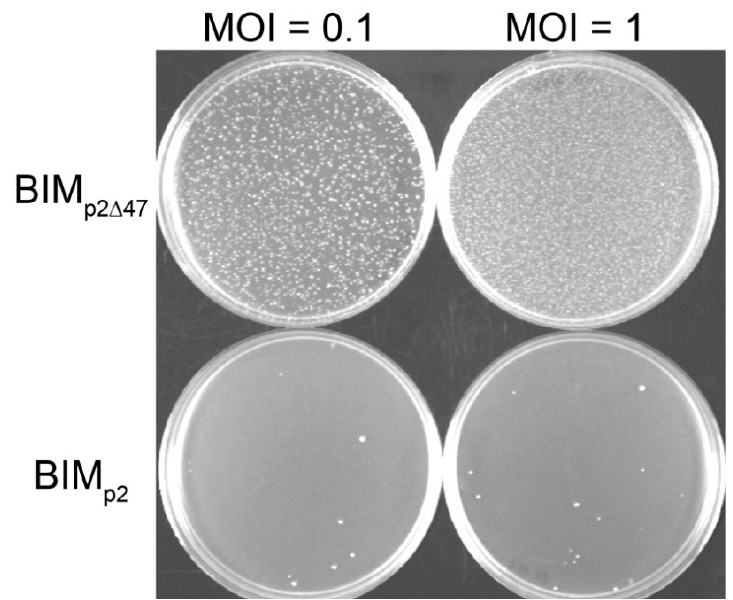
Figure 3. Frequency of natural BIMs generated following the infection by either phage p2 or phage p2 ∆ 47. The number of BIMs obtained following p2 infection ( bottom ) is significantly lower than the number of BIMs obtained following p2 ∆ 47 infection ( top ). This bacterial resistance to phage p2 ∆ 47 was observed at all MOIs tested (only 0.1 and 1 are shown).